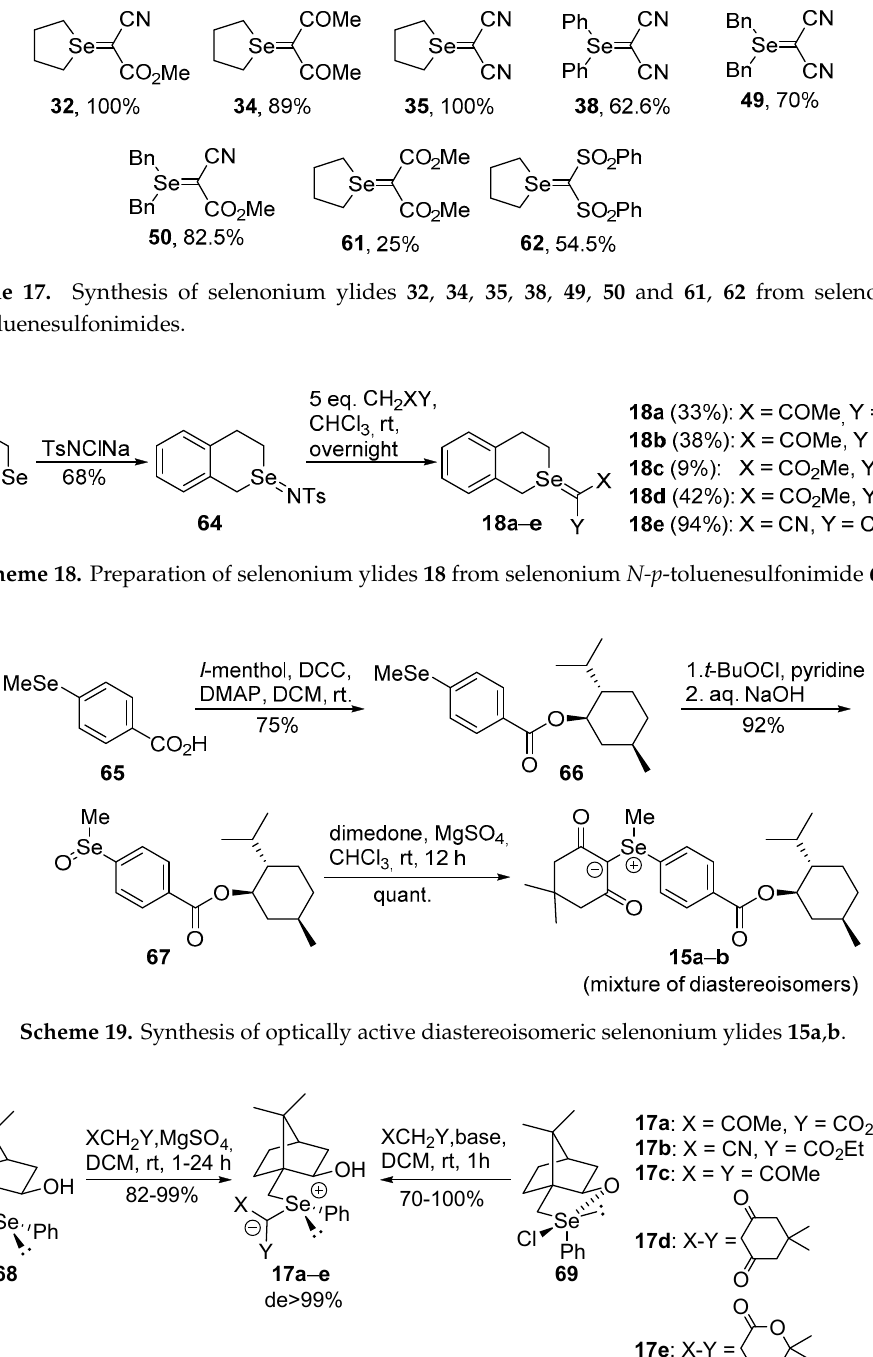
Scheme 20. Reaction of optically active selenoxide 68 and chloroselenurane 69 with activated methylene compounds.